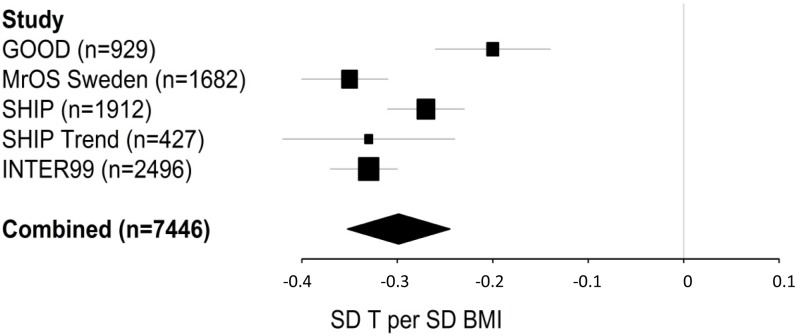
Observational estimates.An increased BMI is associated with a decreased serum testosterone (T). Linear regression models were used adjusting for age, smoking, site and time of day for blood sample, when applicable. The combined effect was calculated with random effect meta-analysis (I-squared = 82%, p = 0.0005) using all cohorts (n = 7446). Effect sizes are given in standard deviations (SD) of T per SD ln-transformed BMI. Horizontal bars represent 95% confidence intervals.